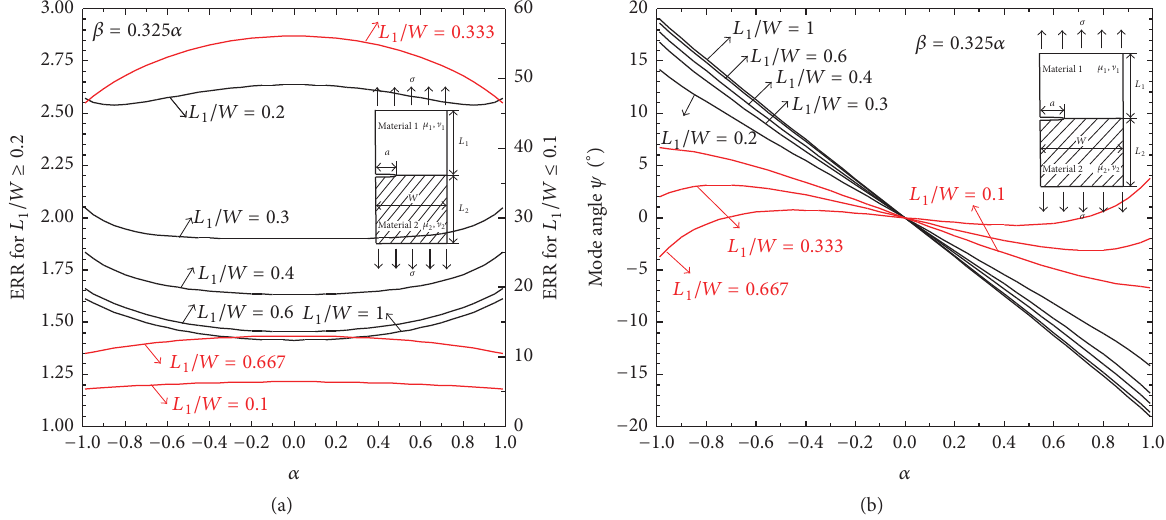
Figure 9: Variations of (a) normalized ERR 𝐺𝐸 ∗ /(𝜎 2 𝜋𝑎) and (b) mode angle 𝜓 of a symmetrically bonded strip for 𝛽 = 0.325𝛼 .